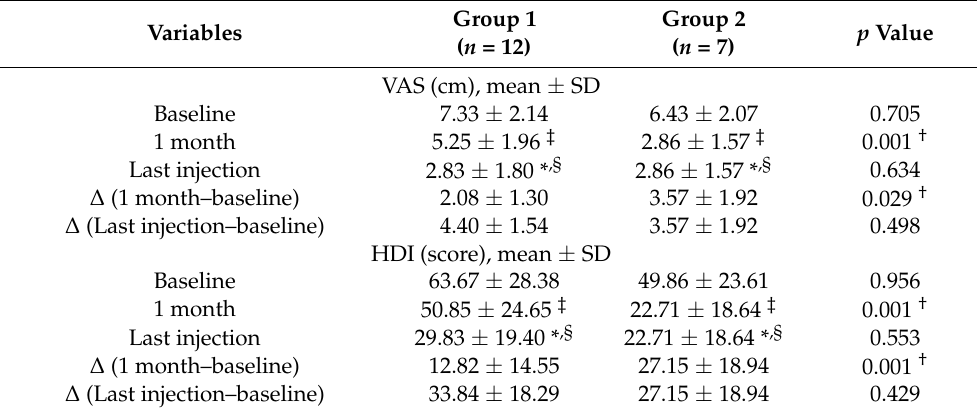
Table 2. Comparison of visual analog scale and headache disability inventory scores.